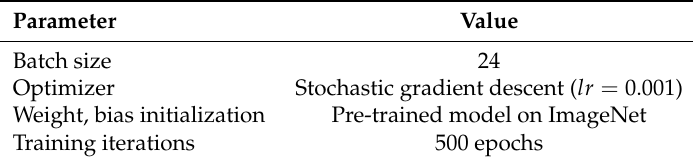
Table A4. ResNet101 hyperparameters and training